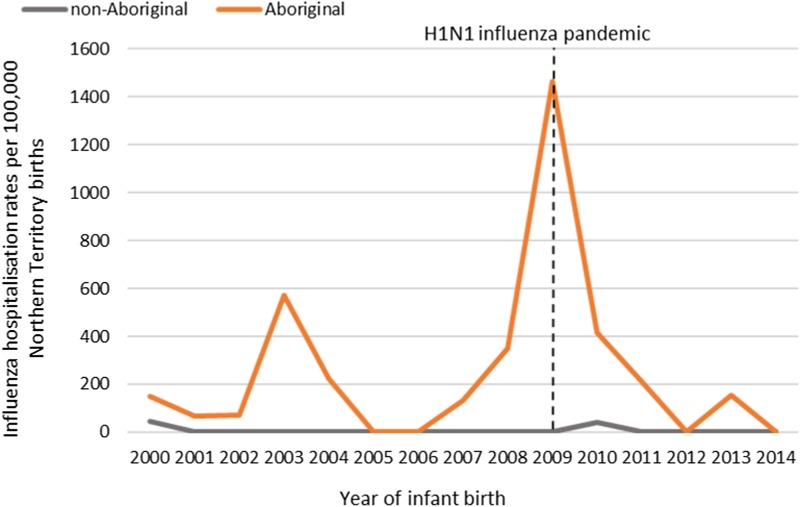
Influenza hospitalisation rates in 0–<7 month old infants, by year of infant birth in the Northern Territory, Australia (2000–2014).